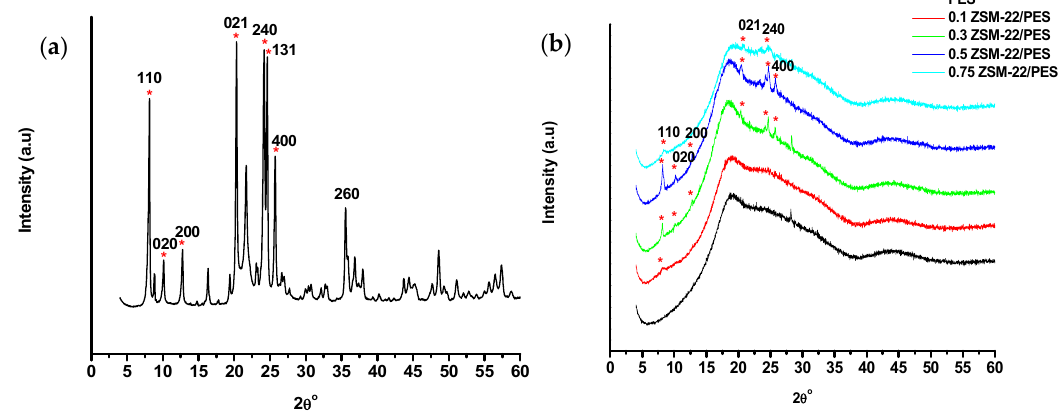
Figure 1. XRD patterns of ( a ) ZSM‐22 material and ( b ) ZSM‐22/polyethersulfone (PES) nanofiltration/reverse osmosis (NF/RO) membranes, respectively, prepared via hydrothermal synthesis approach and direct phase inversion method.